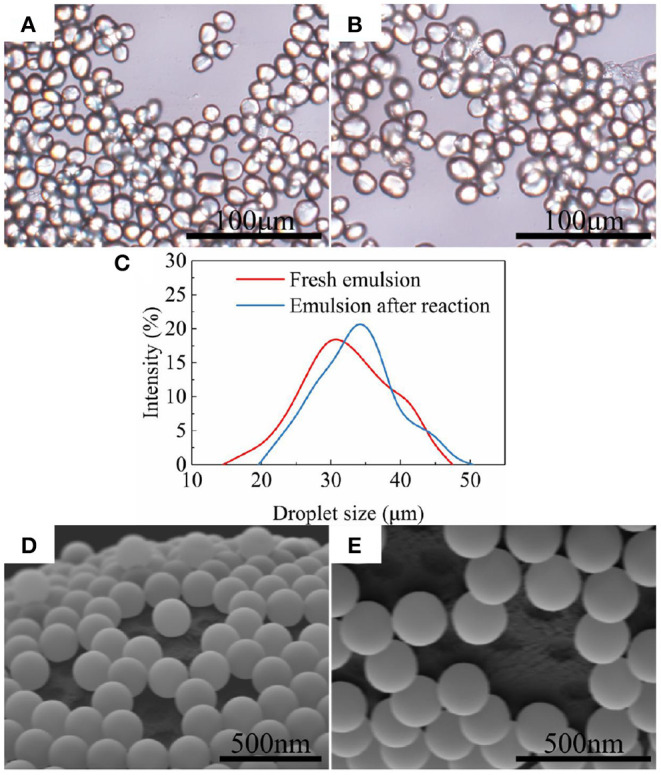
SiO2 particles and pits on Pickering emulsion droplets. (A) Optical micrograph of the emulsion before APS modified; (B) Optical micrograph of the emulsion after APS modified; (C) Size distribution of wax droplets before and after modification. (D) SEM image of the emulsion before APS modified; (E) SEM image of the emulsion after APS modified.